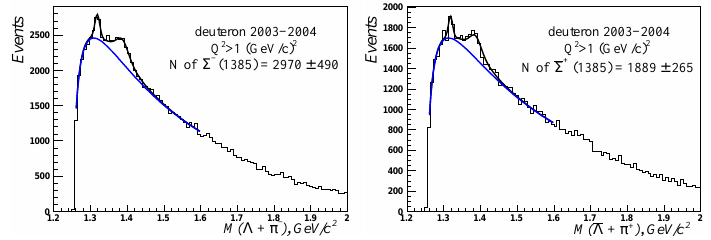
The numbers of events after the fit were found to be N ( Σ + ) = 3631 ± 311, N ( Σ − ) = 2970 ± 490, N ( ¯ Σ − ) = 2173 ± 222 and N ( ¯ Σ + ) = 1889 ±